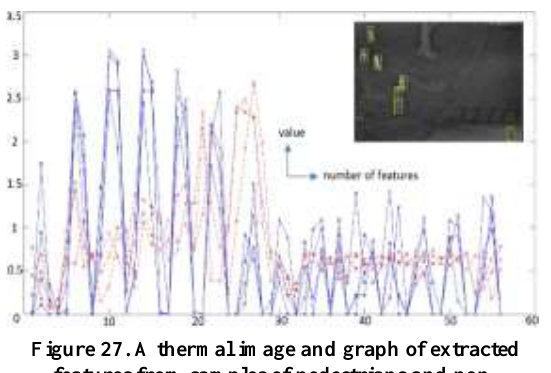
Figure 27. A thermal image and graph of extracted features from samples of pedestrians and non- pedestrians.